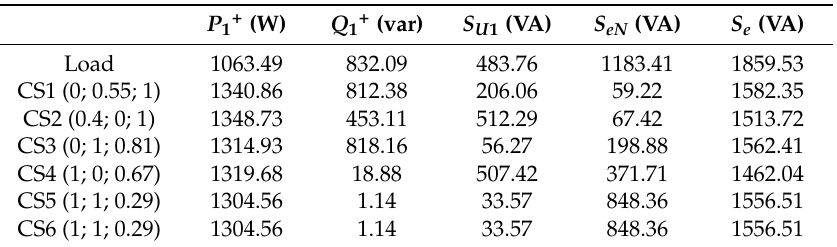
Table 5. Power magnitudes for load and network for the six CS.